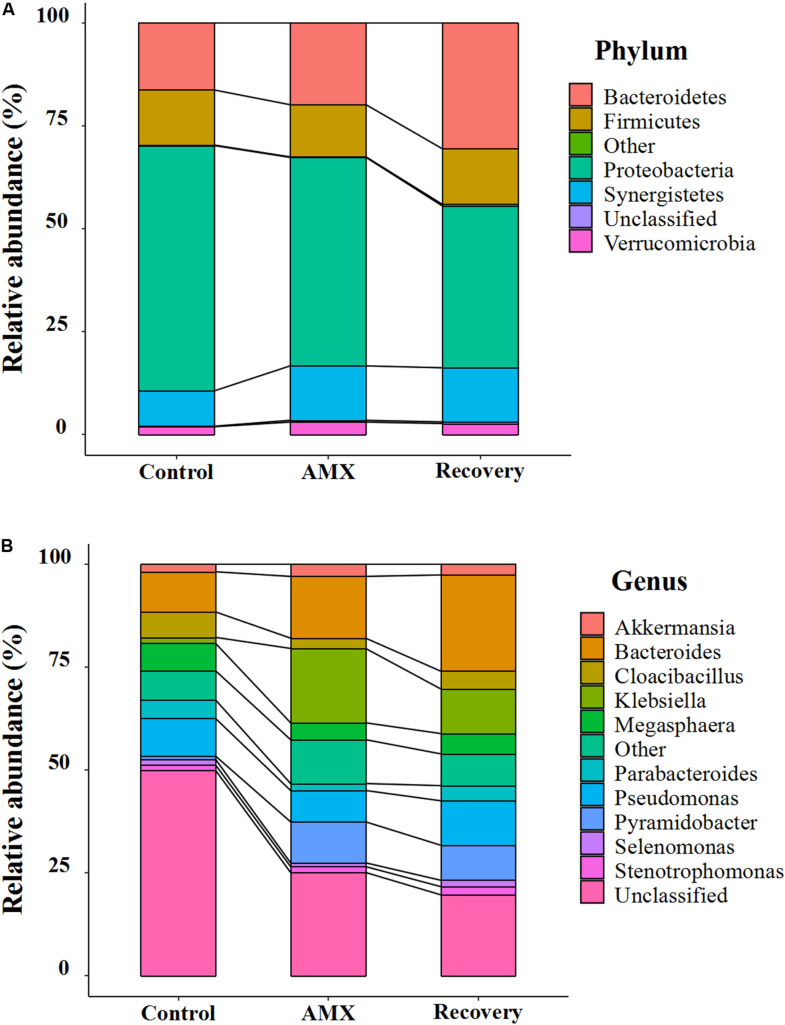
Composition shifts of gut microbial community at phylum (A) and genus level (B) between each of the three groups (control, AMX, and recovery).